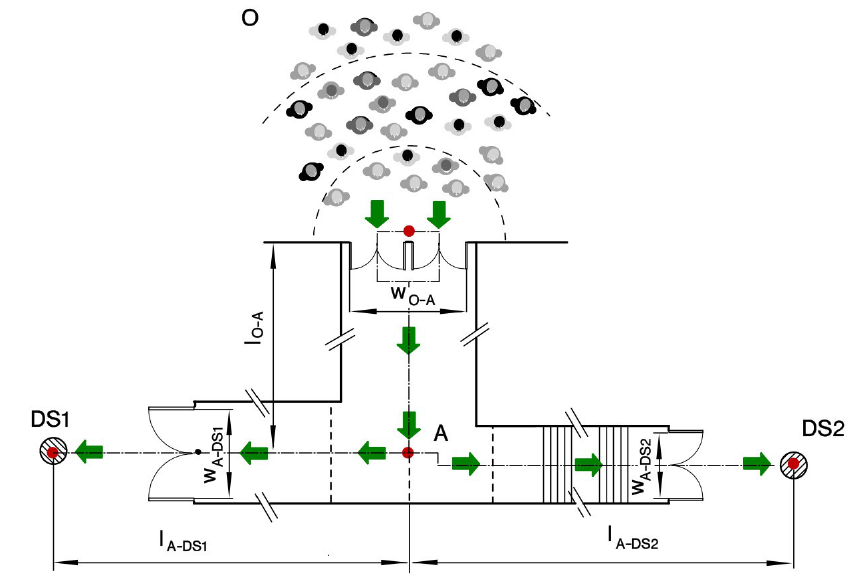
Figure 23. Values of a simple branch dynamic